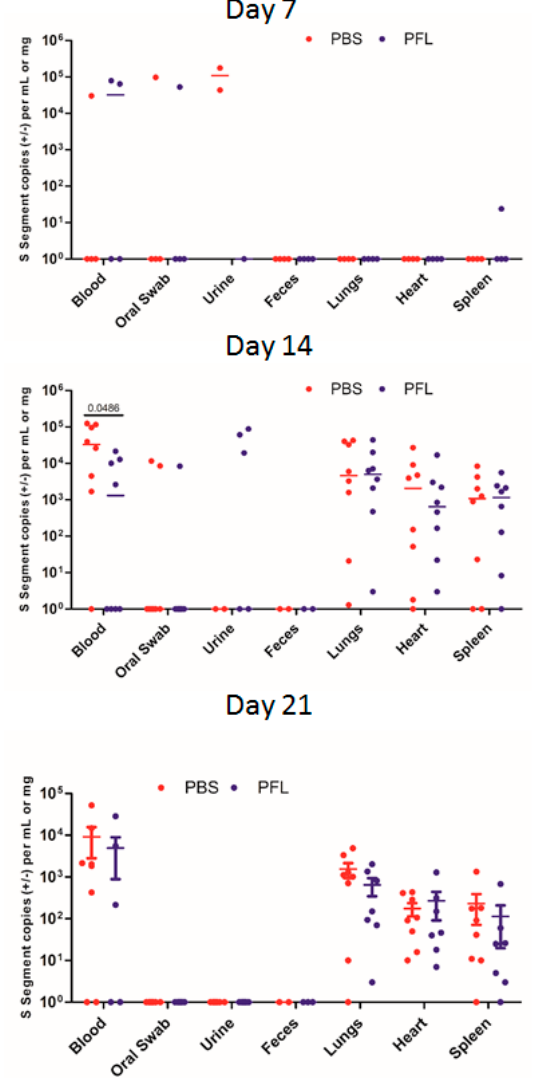
Figure 3. Replication and shedding of SNV in control and paeoniflorin (PFL)-treated deer mice. The SNV viral copy number was assessed in the tissues and samples listed at the indicated time points post-infection. The numbers indicate the p value as assessed by a Mann–Whitney test.